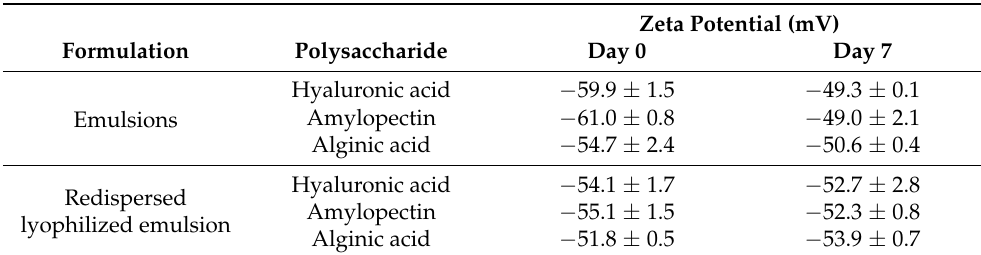
Table 5. Zeta potential measurements of emulsions and redispersed lyophilized emulsions and the oil leakage from lyophilized emulsion powders ± S.D.